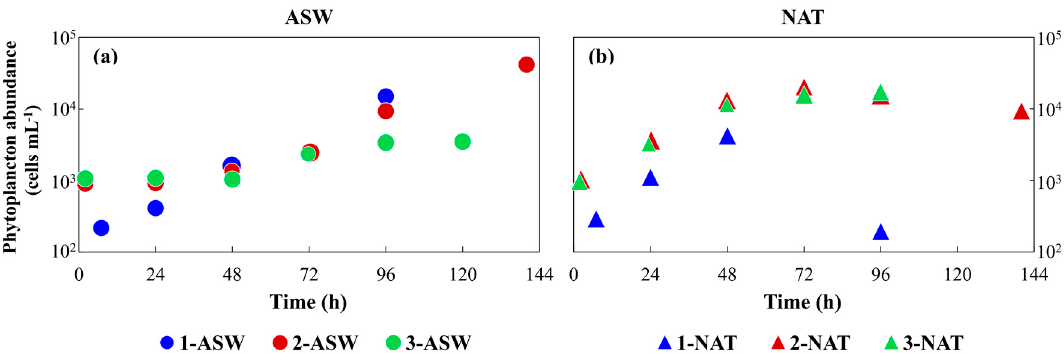
Figure 2. Time variation of T. rotula abundance during the three experiments of phytoplankton culture in ( a ) artificial seawater medium (ASW; represented by circles) and ( b ) natural seawater medium (NAT, represented by triangles). Blue symbols represent the first experiment (EXP-1), red the second experiment (EXP-2) and green the third experiment (EXP-3). Phytoplankton abundance is shown in a logarithmic scale.